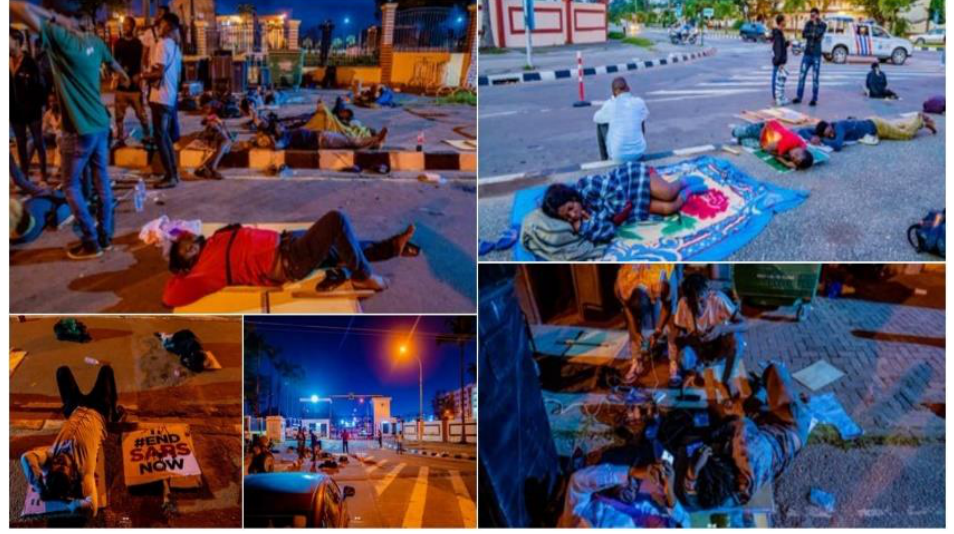
Figure 4: #EndSARS protesters sleeping at the Lagos House of Assembly; Source: Ososanya,